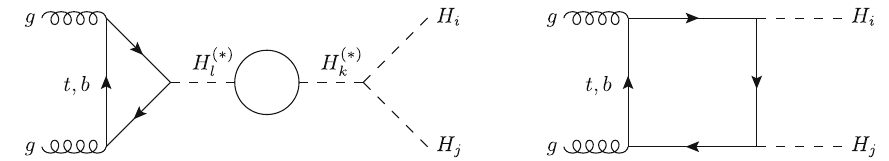
Fig. 1 The Feynman diagrams contributing to Higgs boson pair-production in a model with an extended Higgs sector, but no additional particle content besides the SM